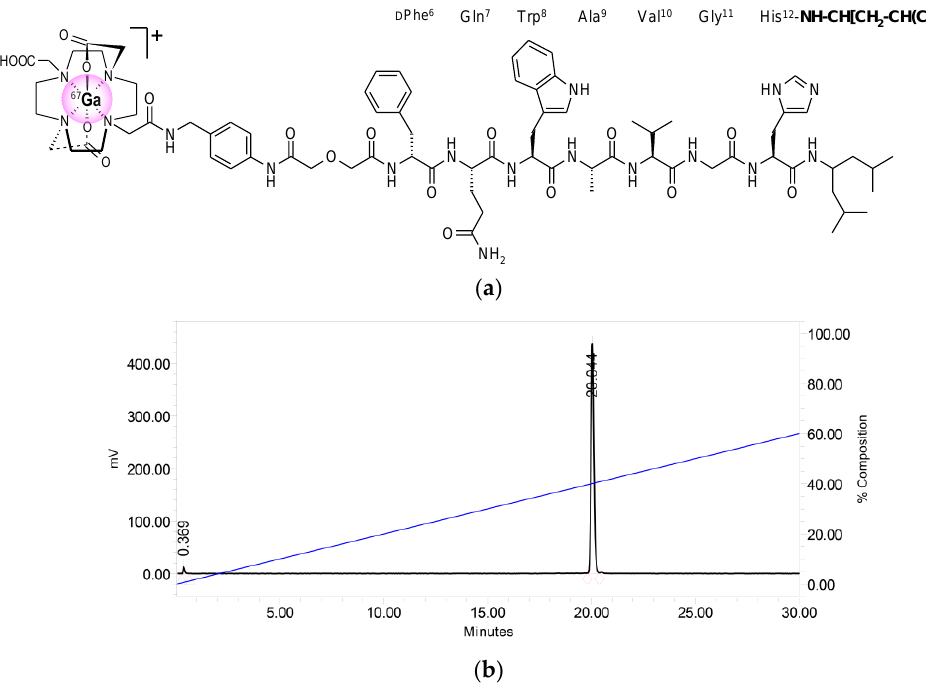
Figure 1. Radiolabeling of NeoBOMB1 with 67 Ga: ( a ) Chemical structure of [ 67 Ga]NeoBOMB1 radioligand; ( b ) Radiochromatogram of HPLC analysis of [ 67 Ga]NeoBOMB1 labeling reaction mixture, showing a quantitative formation of high purity radioligand eluting at t R = 20.0 min.